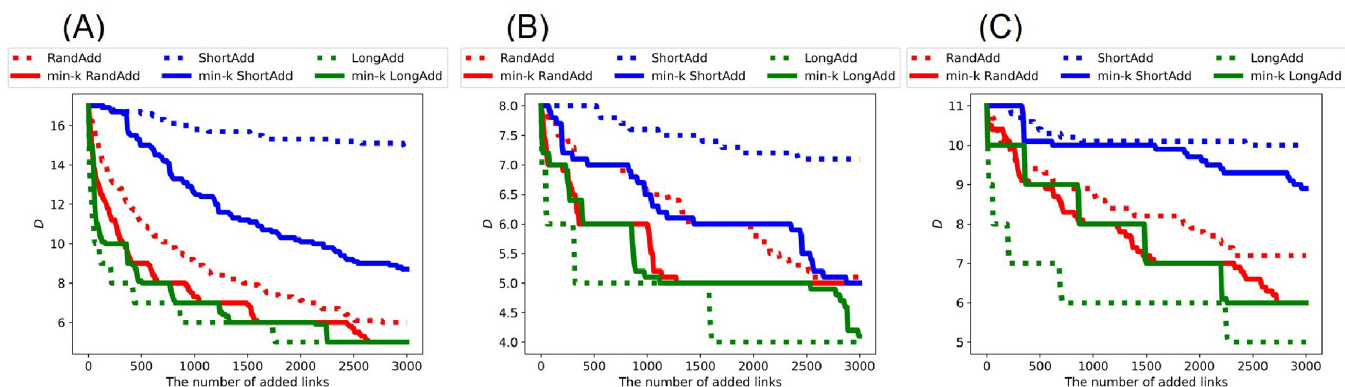
Fig 13. Diameter after adding links to real networks. The LongAdd method (green dotted line) is the most effective for decreasing D among the six methods. The min- k ShortAdd method (blue solid lines) becomes close to RandAdd method (red dotted line). The initial networks are (A) AirTraffic, (B) Email, and (C) Yeast. The correspondence between lines and methods is same as shown in Fig